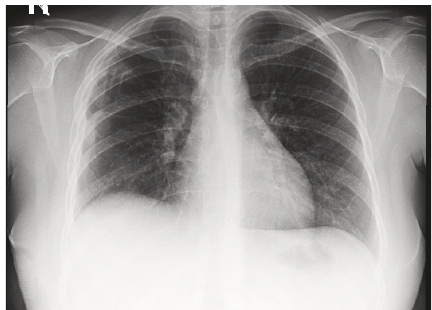
Figure 4: Chest X-ray on discharge showing resolution of the bilateral lung infiltrates, pleural effusions, and surgical